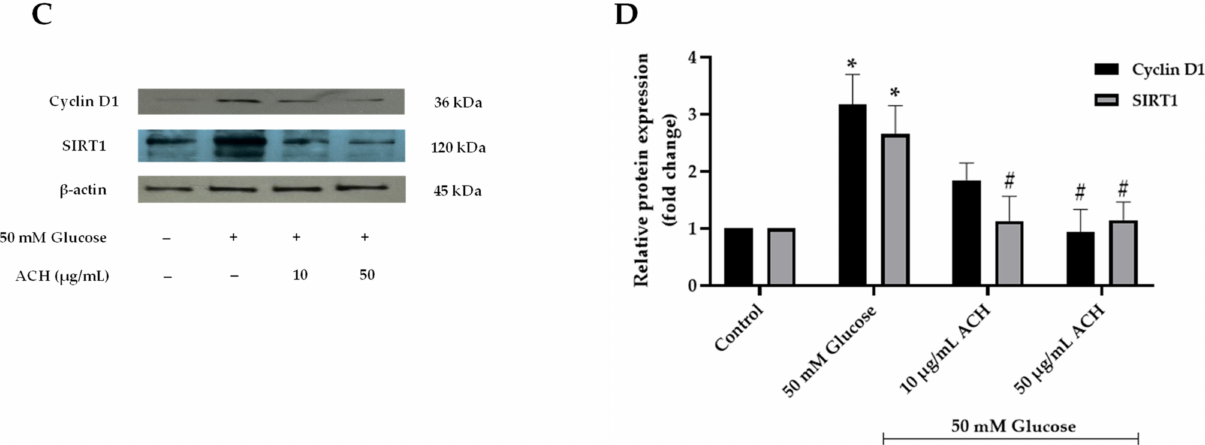
Figure 3. The neuroprotection of ACH on high glucose-induced cell cycle delay. Quantitative determination based on propidium iodide (PI) staining was carried out using a flow cytometer. Cell histogram ( A ) and the percentage of cell numbers ( B ) are shown. Cyclin D1 and sirtuin 1 (SIRT1) are as shown in a representative Western blot ( C ). Normalized values of both cyclin D1 and SIRT1 against β -actin ( D ). The mean ± SEM values of normalized cyclin D1 and SIRT1 expression were obtained from three independent experiments, * p < 0.05 vs. control; # p < 0.05 vs. 50 mM